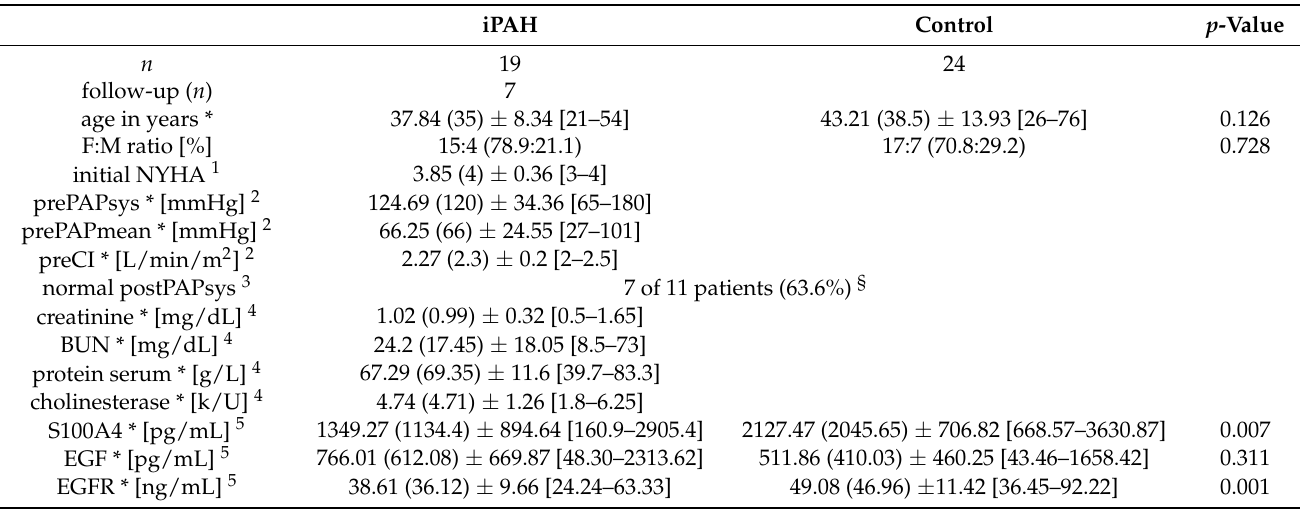
Table 2. Basic demographic and hemodynamic data of iPAH patients. Several serum parameters of iPAH patients are shown. Concentrations of EndMT biomarkers in iPAH patients and healthy controls are reported. Controls were age- and